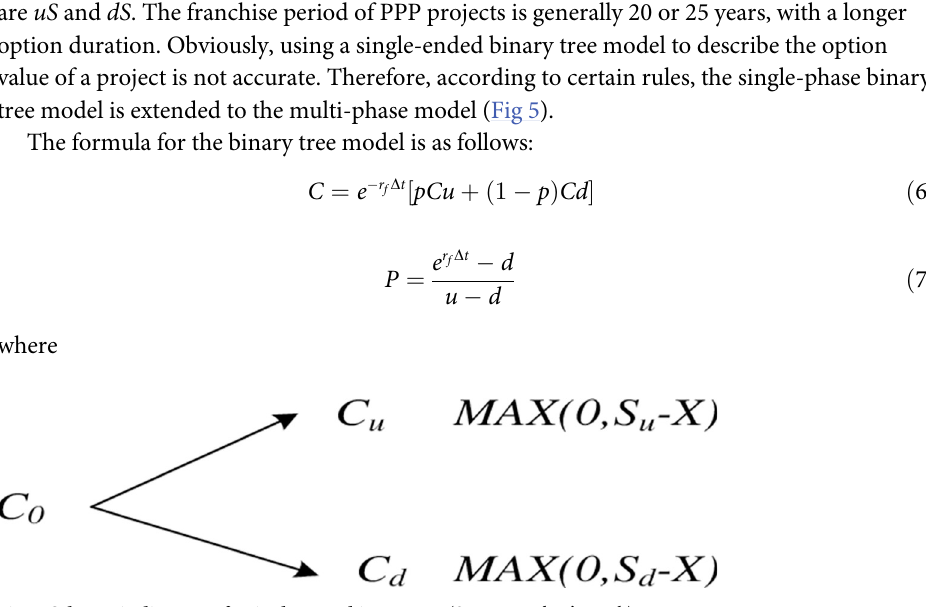
Fig 4. Schematic diagram of a single-stage binary tree. (Source: author’s work).